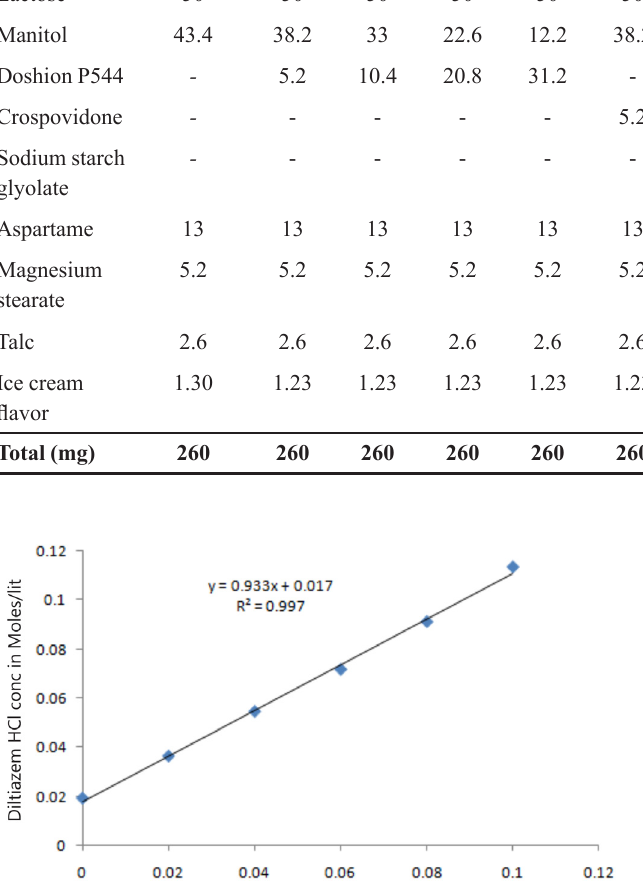
TABLE I - Formulae used in the preparation of tablets Ingredients Control (mg) formulation Drug-β-CD complex